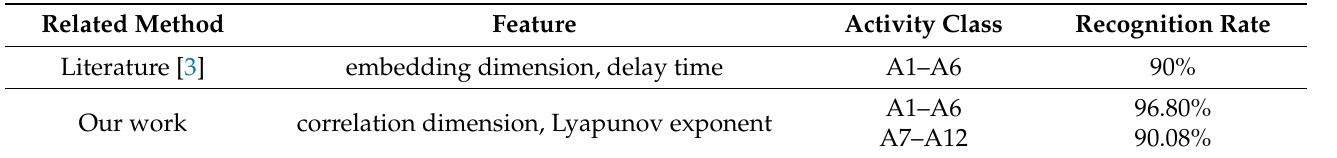
Table 5. The LLE of all